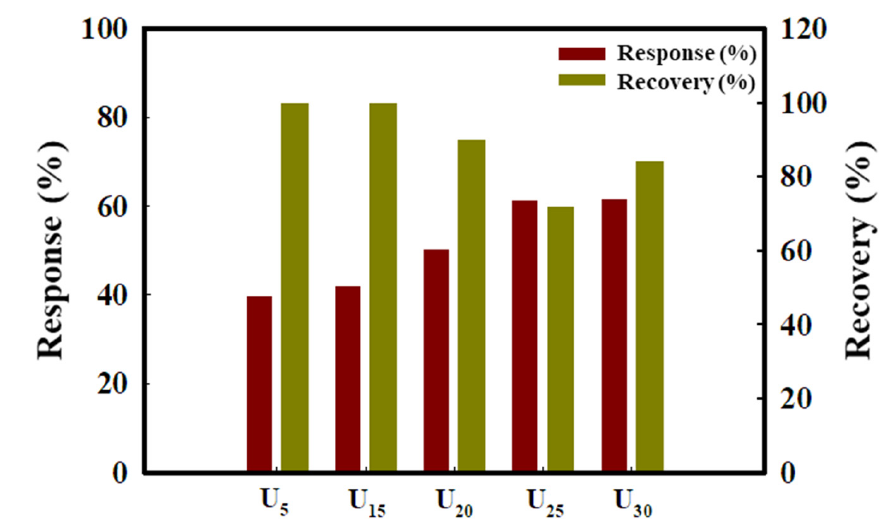
Figure 4. Response and recovery of the ZnO nanostructure sensors for 20 ppm toluene gas.